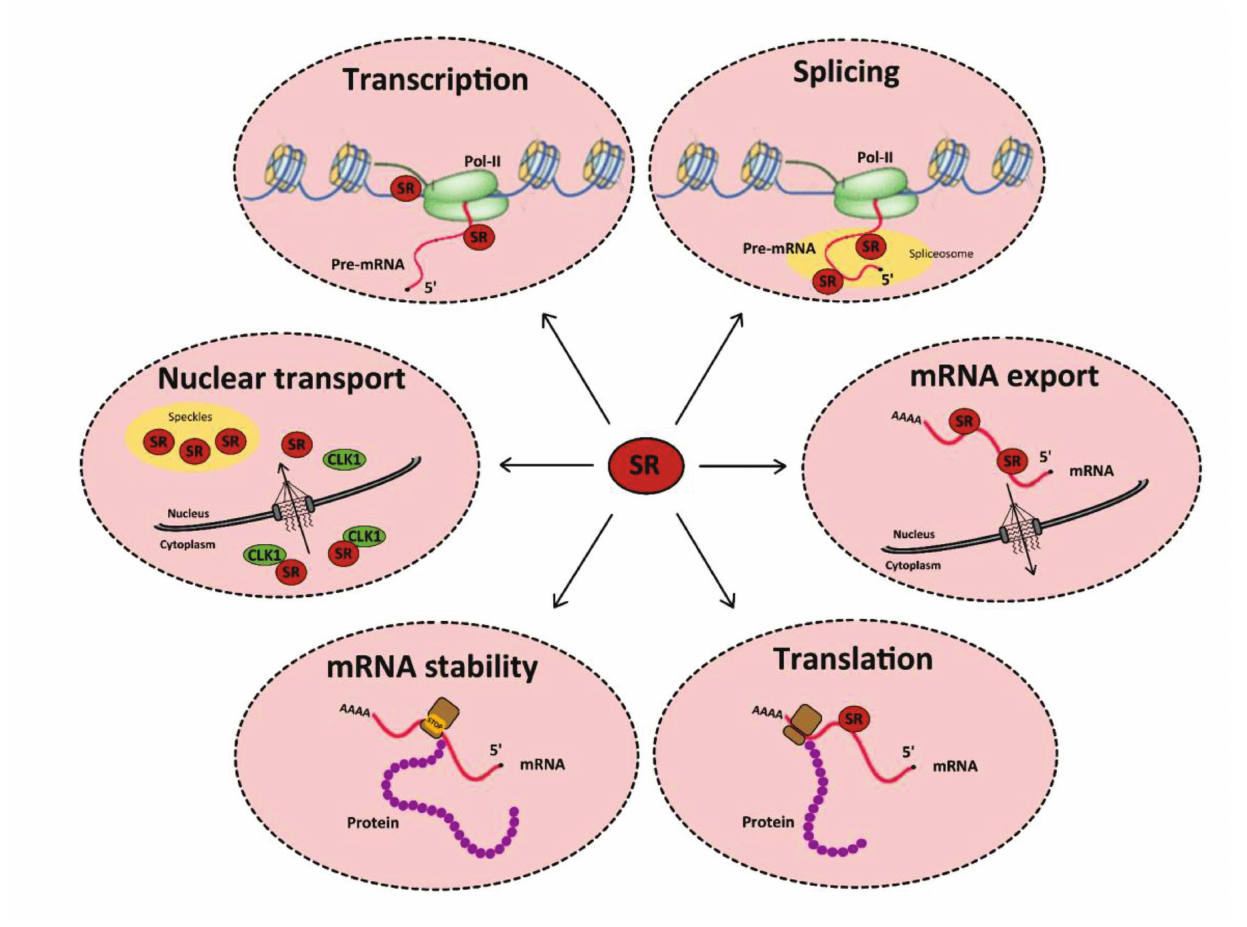
FIGURE 1 | Functions of serine/arginine-rich (SR) proteins in mRNA metabolism. SR proteins (red circles) regulate transcription by activating the RNA polymerase II (in green). They also regulate constitutive and alternative splicing of pre-mRNAs by the spliceosome (in yellow). After splicing, SR proteins remain linked to mRNAs and some of them are involved in their nucleocytoplasmic export. In the cytoplasm, SR proteins can be redirected to the nucleus or regulate mRNA translation and/or stability: indeed, splicing regulation by SR proteins can induce the inclusion of a premature stop codon, which favors the recruitment of cellular proteins involved in RNA degradation by the non-sense mediated decay (NMD) pathway. Finally, some SR proteins can be involved in the nuclear import of Cdc2-like kinase 1 (CLK1). All these functions are tightly regulated by multi-site phosphorylation of SR proteins that also modulates their subcellular localization in the cytoplasm and the